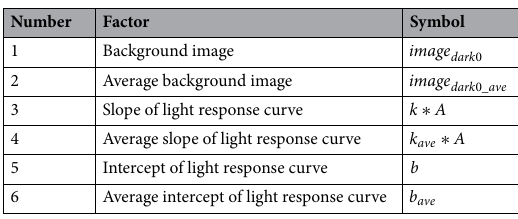
Table 1. Correction factors to be